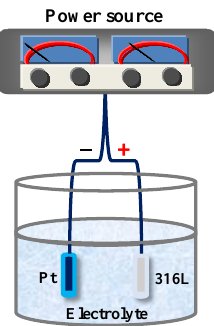
Figure 1. A schematic diagram showing the experimental setup used for surface modification.